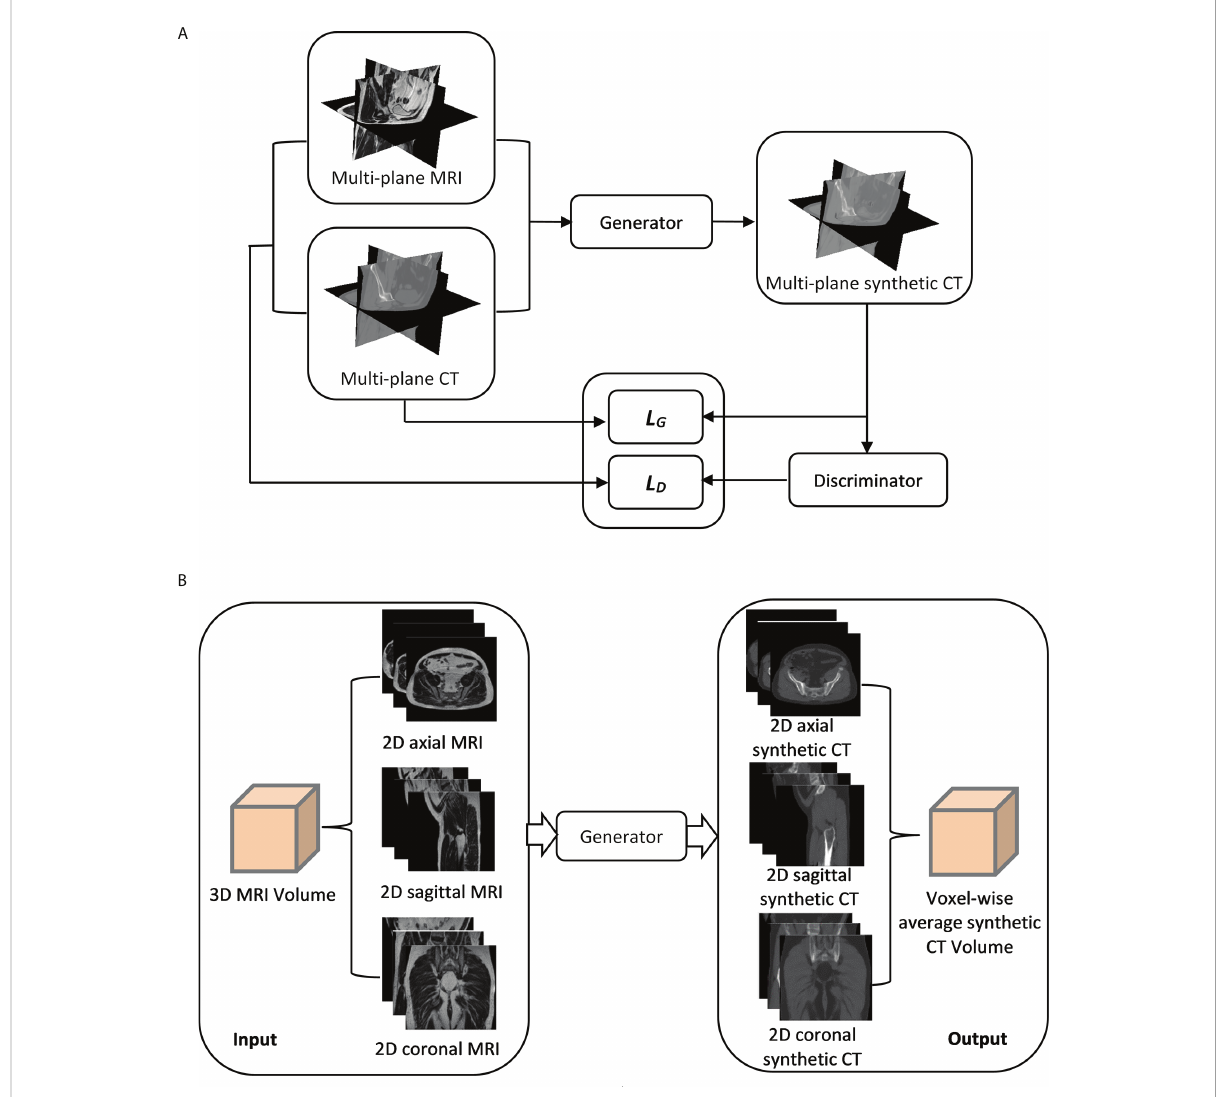
Figure 1B. As a result, three predictions were acquired for each voxel. Predicted values from the outputs in all three directions were then averaged to obtain the fi nal synthetic CT volume (sCT ave ). The synthetic CT generation was performed using an in-house program, written in